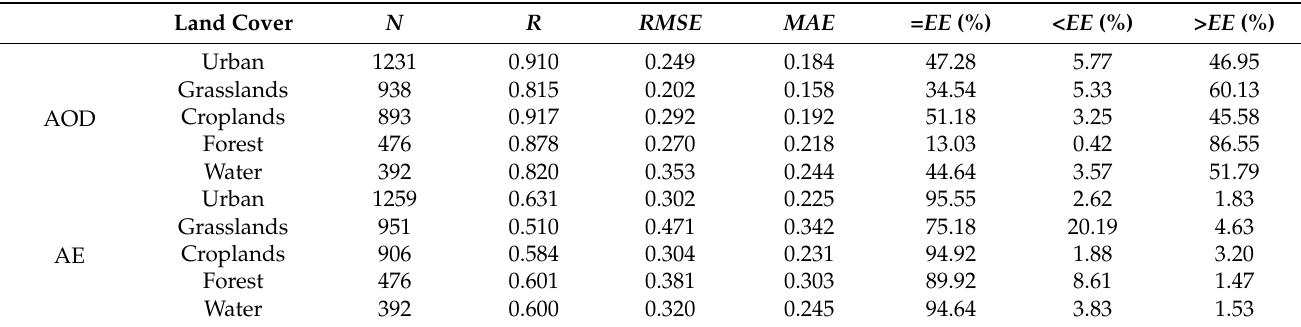
Figure 3. Validation of POLDER-3/GRASP aerosol products in 0.5 ◦ × 0.5 ◦ resolution with 34 AERONET stations in China: ( a ) AOD; ( b ) AAOD; ( c ) AE. The probability density functions of differences are present in the same order as in the lower panel (( d ) AOD; ( e ) AAOD; ( f ) AE). The black, blue, and red solid lines indicate AOD conditions: all values, AOD < 0.5 and AOD > 0.5, respectively. Table 5. Validation of POLDER-3/GRASP AOD and AE in 0.5 ◦ × 0.5 ◦ resolution over different land covers in